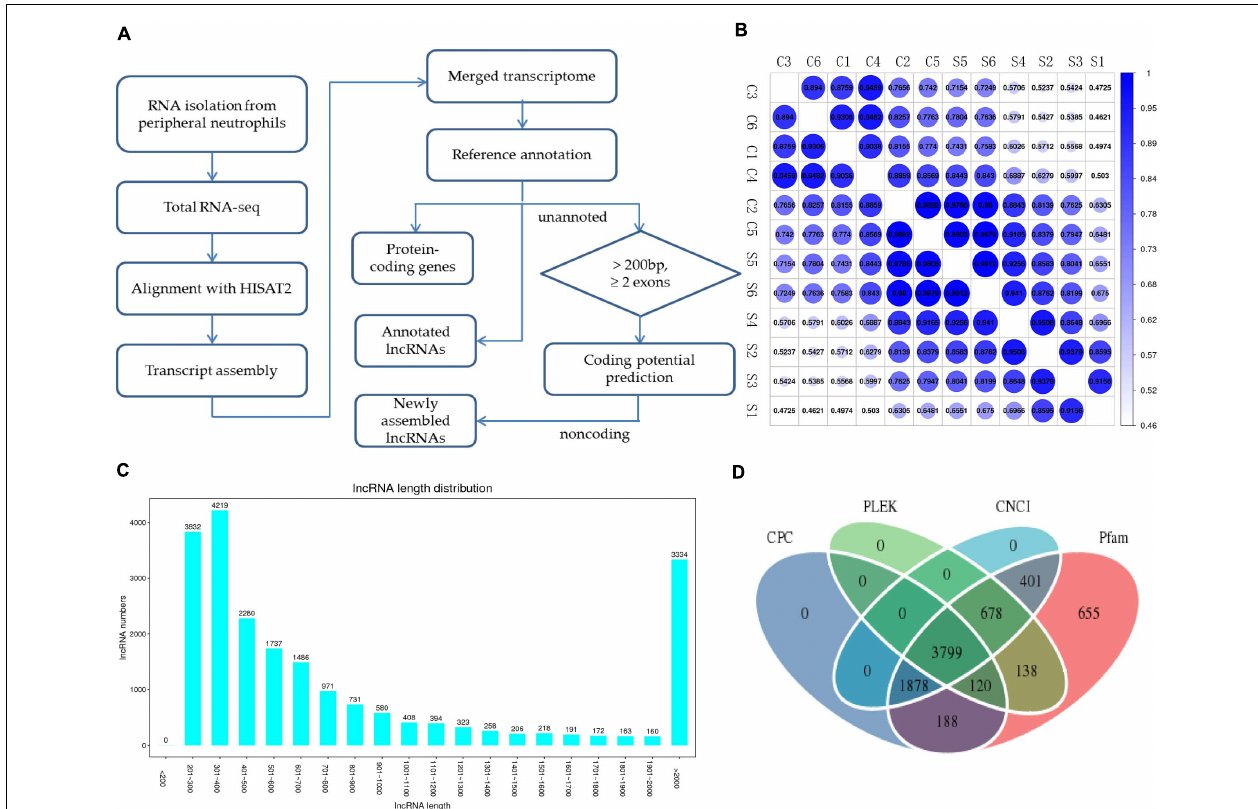
FIGURE 1 | Overview of RNA-seq and lncRNA identification in patients with SAPHO syndrome. (A) Experimental and computational scheme for RNA-seq and identification of lncRNAs in the samples. (B) Correlation coefficient map between samples. (C) Average lncRNA length distribution of the 12 samples. (D) Venn diagram illustrating the distribution of the lncRNAs in the Pfam, CNCI, PLEK, and CPC software databases.